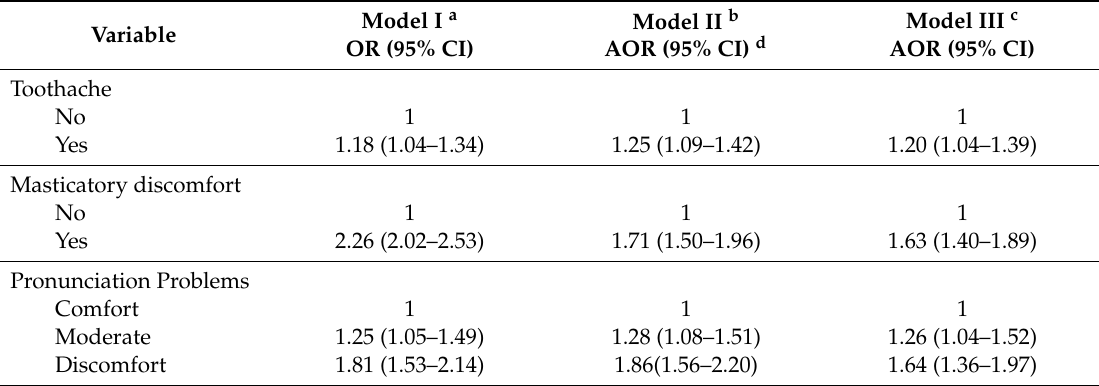
Table 2. Association between oral discomfort problems and health-related quality of life (EQ-5D